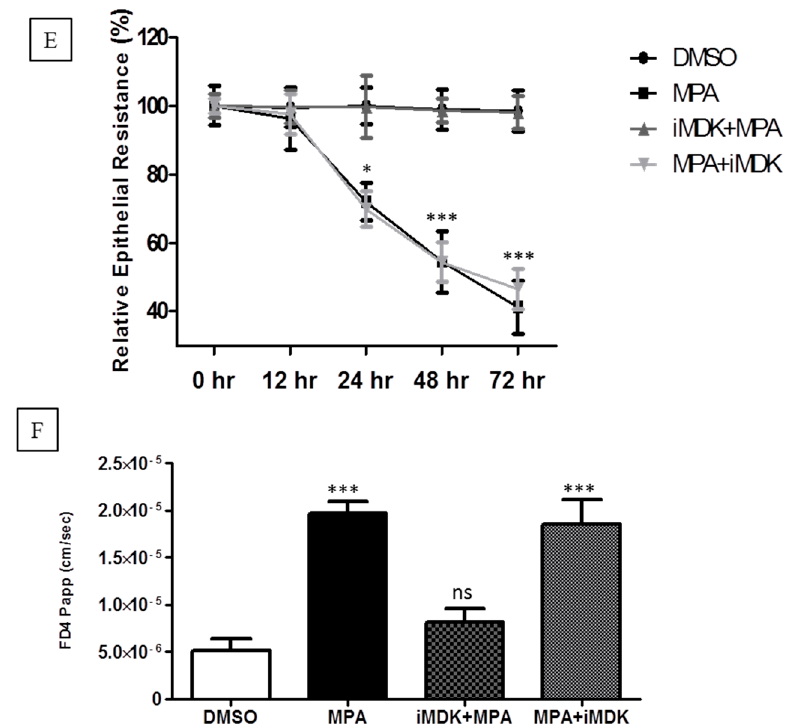
Figure 2. ( A – D ) Influence of MPA (10 µM) on the expression and activation of the midkine gene. ( A ) Quantification of the midkine protein by spectral count after MPA treatment as compared to DMSO (control) cells; ( B ) expression (mRNA) of the midkine gene after MPA treatment. Expression of the mRNA of midkine was investigated using quantitative real-time PCR; ( C , D ) Influence of MPA treatment on the enrichment or depletion of histone active modification mark (H3K4me3) and repressive histone modification mark (H3K27me3) in the promoter of the midkine gene; ( E , F ) Caco-2 cell monolayer integrity. Caco-2 cells were seeded on the transwell insert membrane. Differentiated and polarized Caco-2 cells were treated as described in material and method; ( E ) TEER was measured at the indicated times in the graph; ( F ) following 72 h incubation, FD4 dye was added to the apical chamber and dye concentration was measured in the sample collected from the basal chamber. TEER and FITC-dextran assay results obtained either in presence or absence of midkine inhibitor (iMDK, 25 nM). Error bars indicate means ± SEM. * p < 0.05, *** p < 0.001. Differences between two groups were analyzed by the two-tailed Student’s t -test and for more than two groups analysis of variance (ANOVA) was applied with Bonferroni post-test ( n = 3). ns: non-significant.